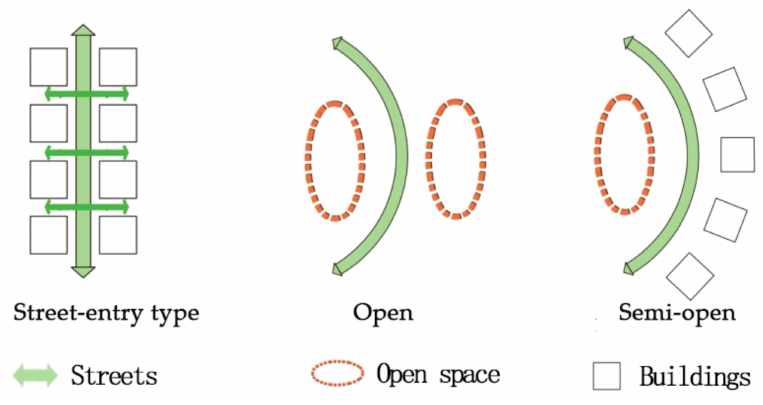
Figure 2. Space types of campus streets.